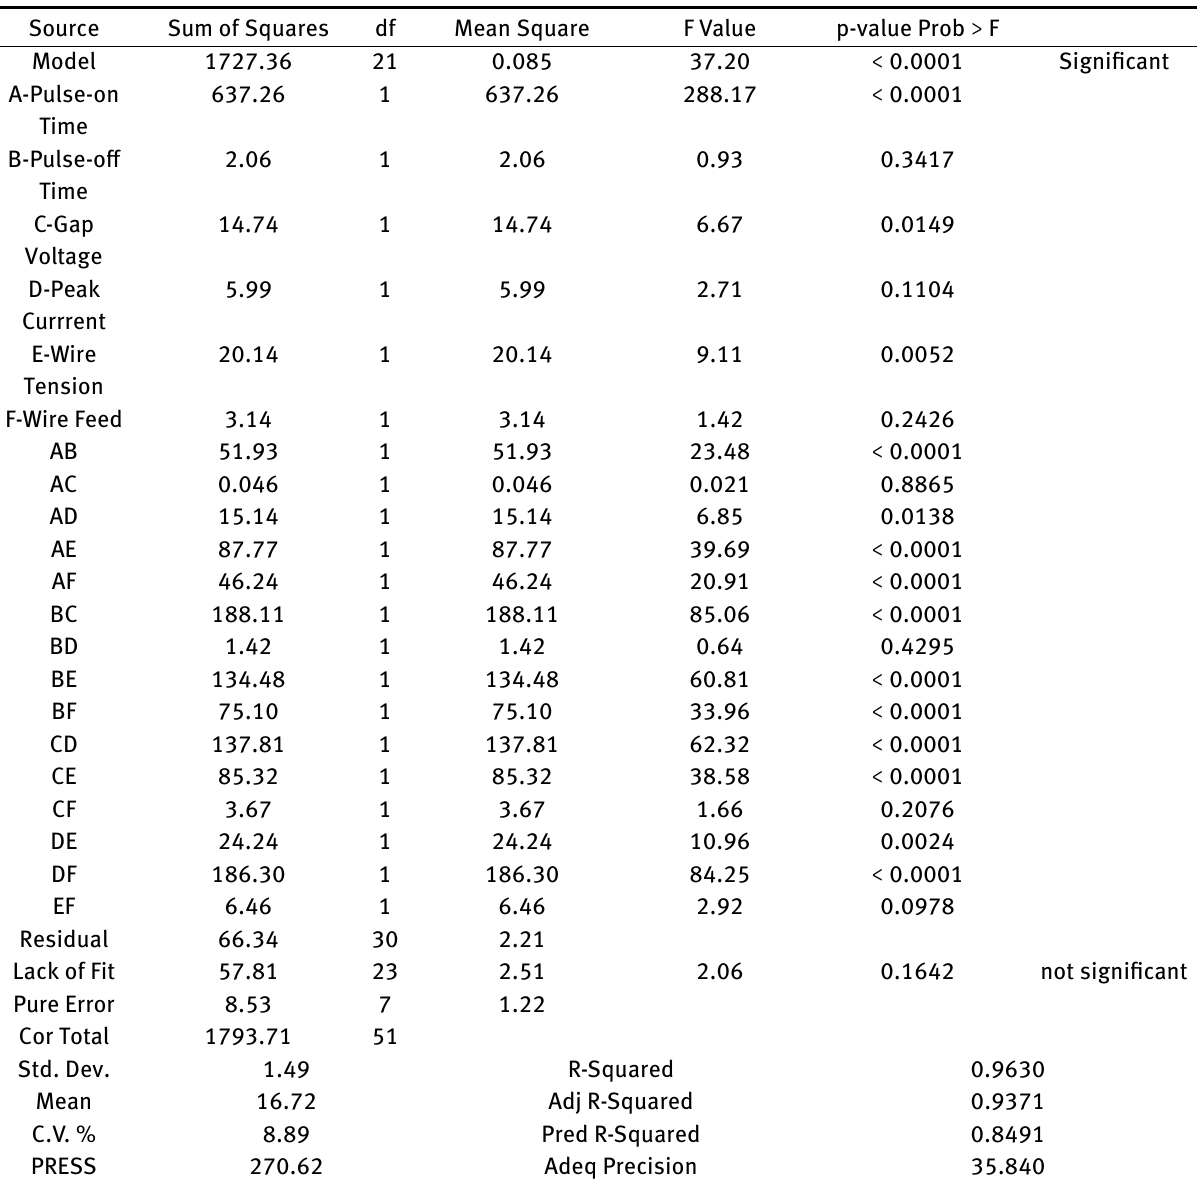
Table 5: Analysis of variance (ANOVA) for response SR